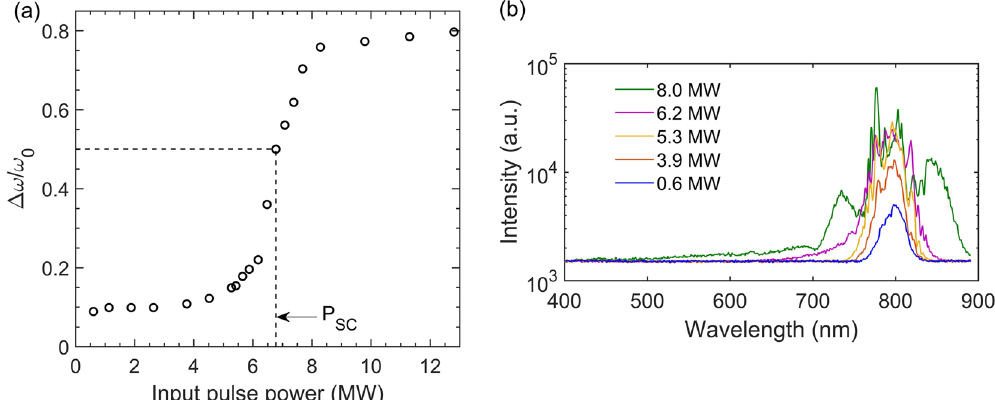
Figure 3. (a) Relative spectral broadening of the pulse as a function of the input power in deionized water. The estimation has been performed as in 12 . Note that the authors of 12 have chosen �ω/ω 0 ( P = P SC ) ∼= 0.5 , so here, P SC is close to 6.7 MW. (b) Experimentally obtained supercontinuum spectra for water as a function of the input